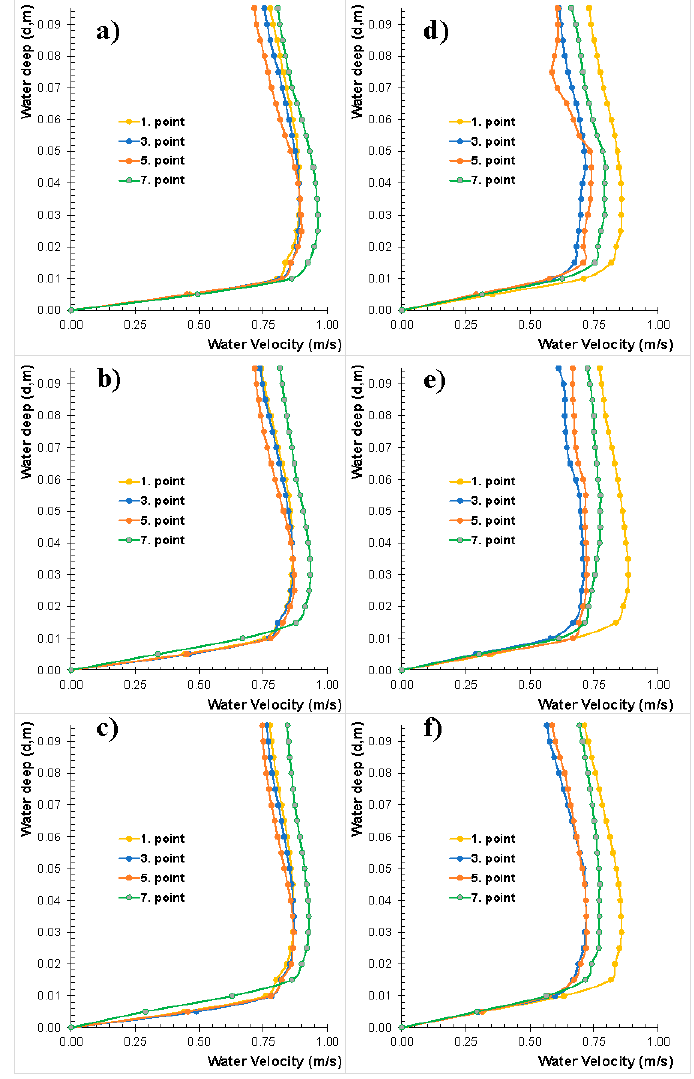
Figure 14. CFD -Velocity changes (m/s) along the water depth (m) in V 0 case points at ( a ) 1-1, ( b ) 2-2, ( c ) 3-3 sections and V 1 case points at ( d ) 1-1, ( e ) 2-2, ( f ) 3-3 sections.